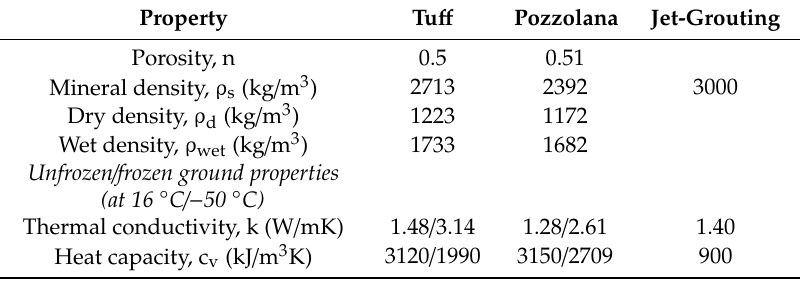
Table 1. Characteristics of the soil layers and jet-grouting ([3,6]).